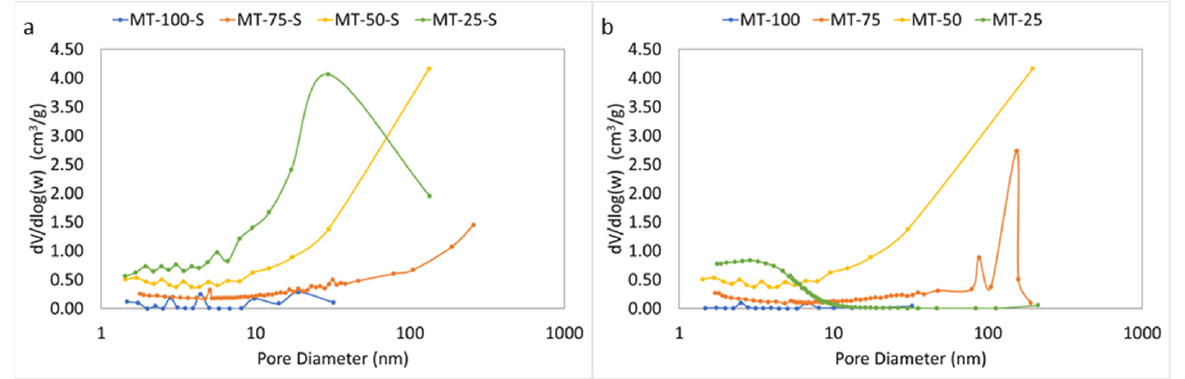
Figure 6. BJH pore size distribution curves of the ( a ) silylated and ( b ) non ‐ silylated silica xerogels.